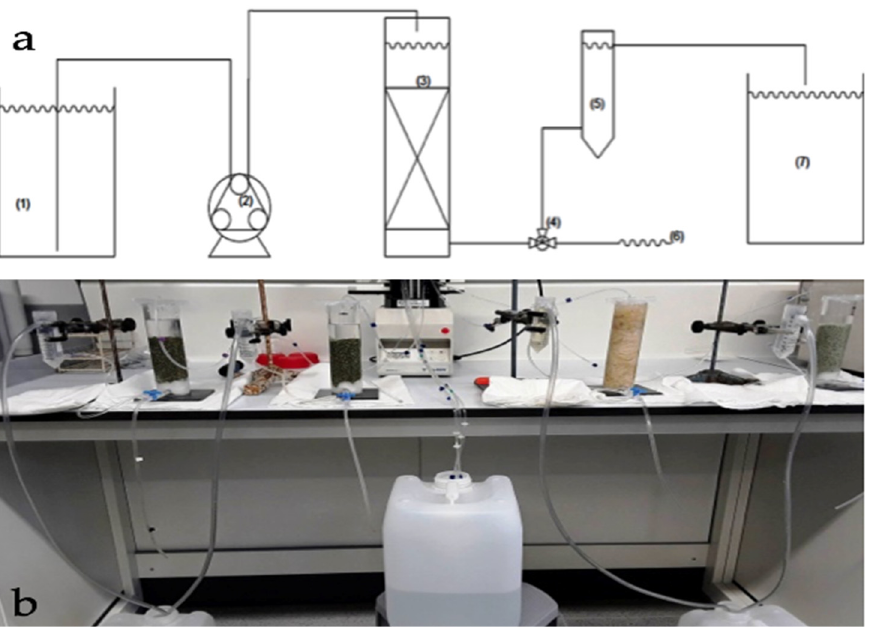
Figure 1. ( a ) Outline of the system used to perform column tests. (1) Reservoir; (2) peristaltic pump; (3) column; (4) three-way valve; (5) container controller of the liquid level in the column; (6) sampling; (7) collector output from the column. ( b ) Photo of the laboratory apparatus used for column tests.